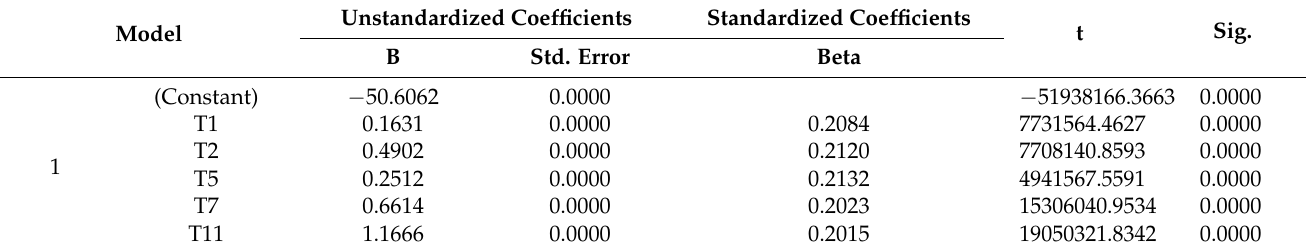
Table 17. Coefficients of principal component